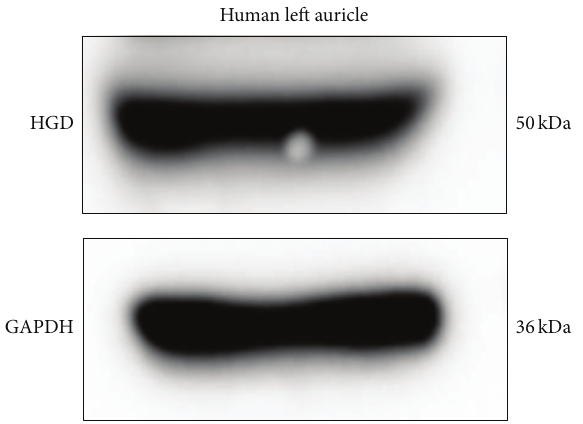
Figure 8: Western blotting with anti-HGD antibody of human aortic valve from a non-AKU patient. Anti-GAPDH antibody as a loading control is